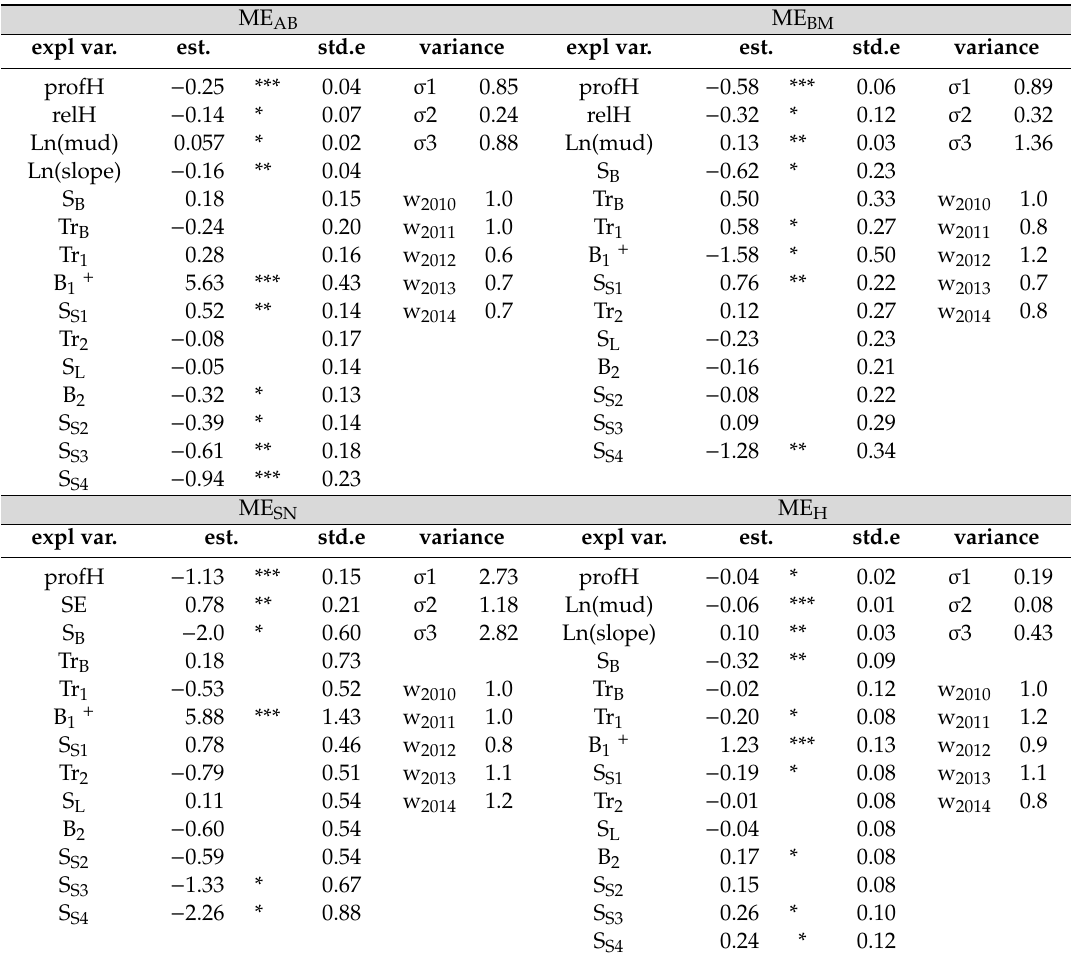
Table 3. Model estimates for the selected explanatory variables (fixed factors) and variance (random e ff ects) for the models predicting, total abundance (ME AB ), total biomass (ME BM ), species number (ME SN ), and diversity (ME H ). ME AB ME BM expl